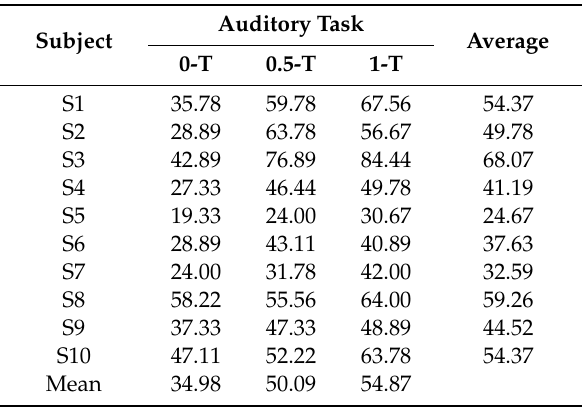
Table 4. Average fatigue